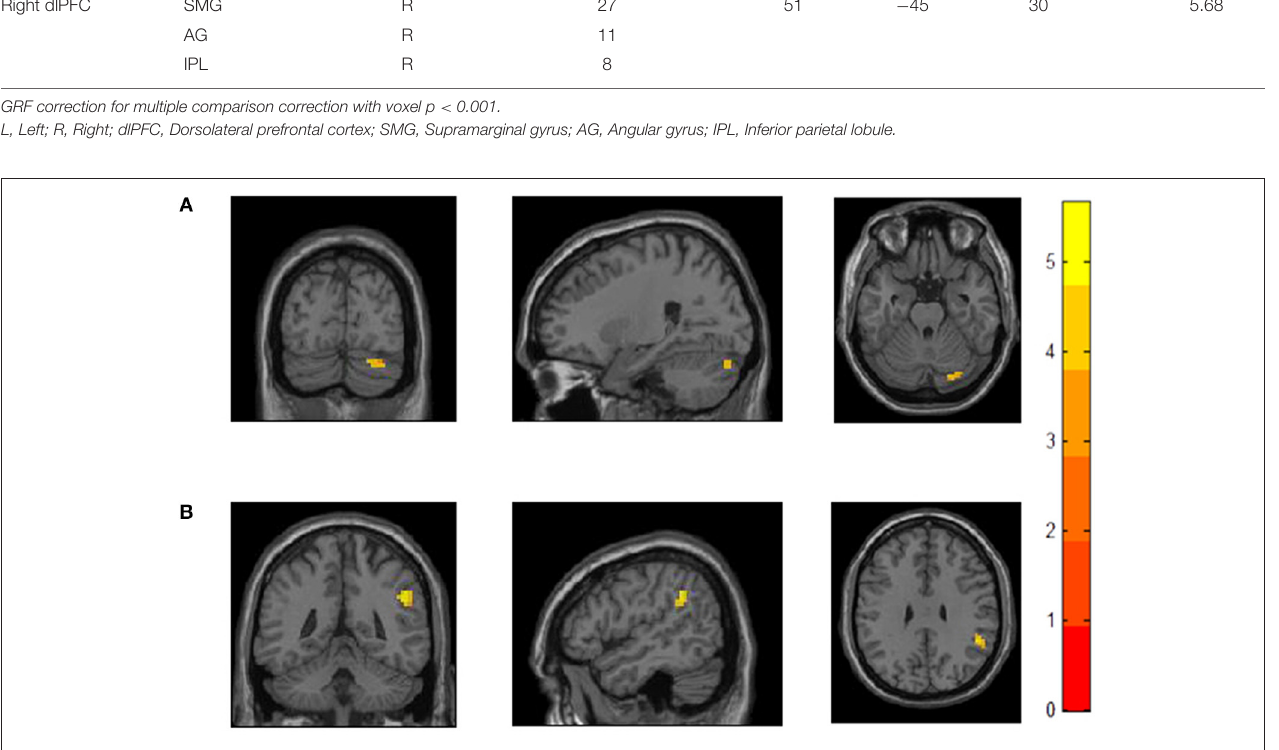
TABLE 2 | Regions showing abnormal connectivity with dorsolateral prefrontal cortex in MDD compared to HC. ROIs Region L/R Cluster size (Voxels) Peak coordinates Peak intensity X y z Left dlPFC Cerebellar Crus I R 34 24 − 81 24 4.67 Right dlPFC SMG R 27 51 − 45 30 AG R 11 IPL